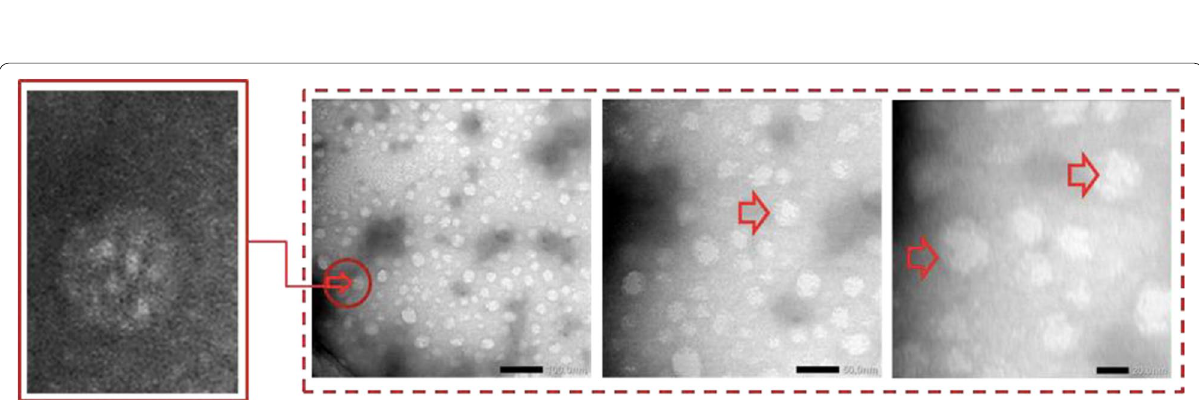
Fig. 9 The TEM examination of assembled particles of L1-HPV52. The protein was incubated in the assembled buffer (pH 5.4) at 25°C for 30 min. Scale bars: 20–200